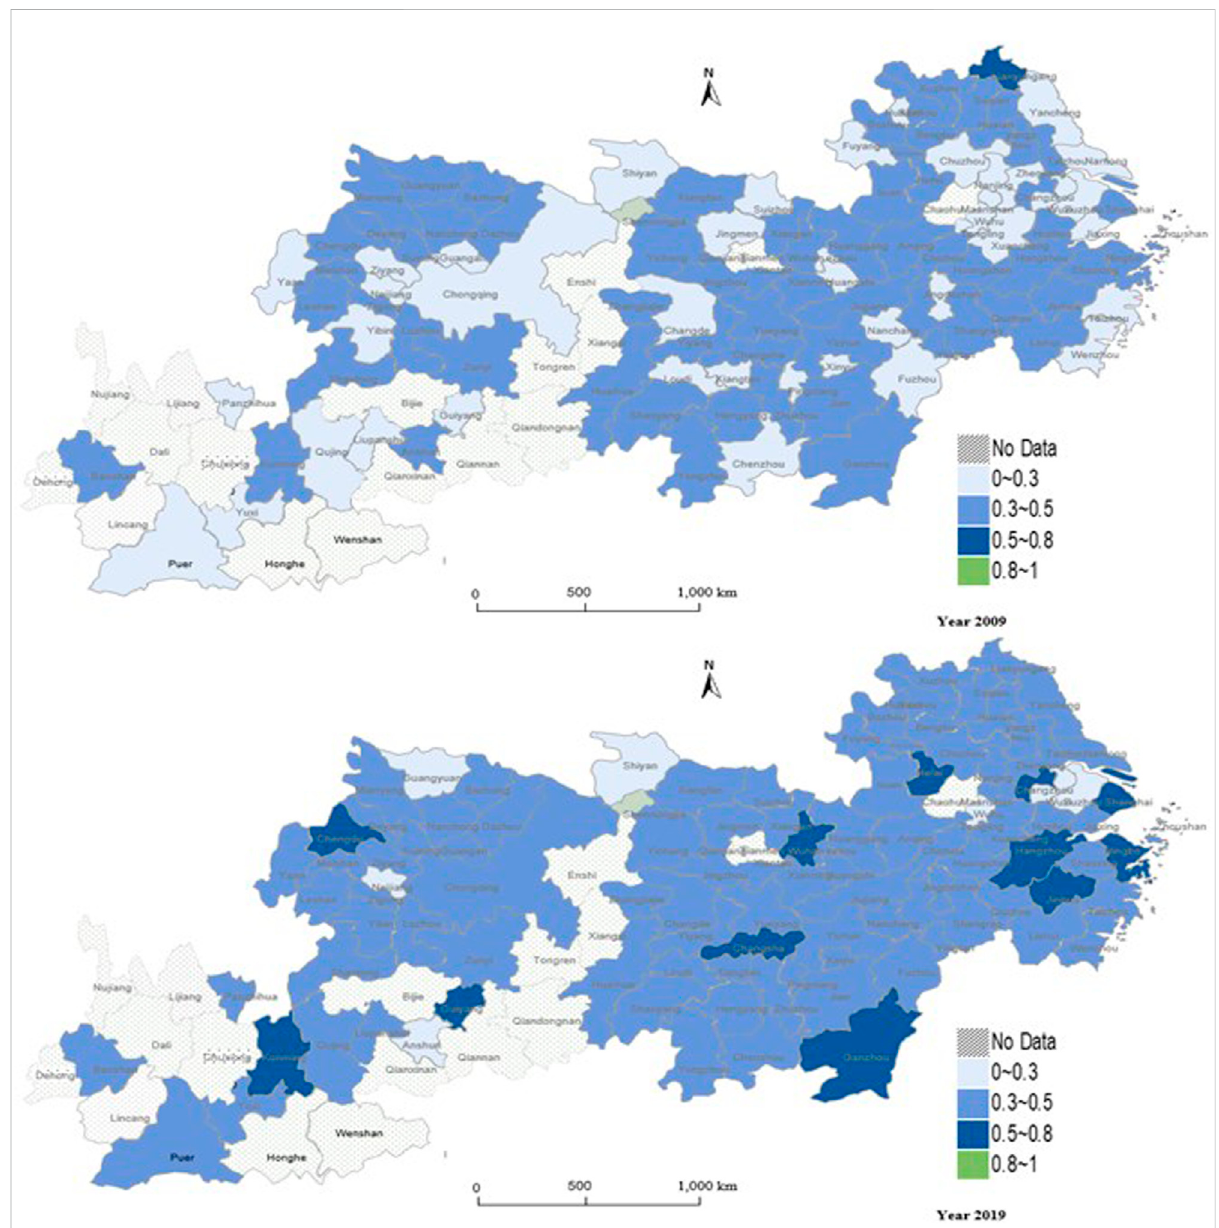
FIGURE 6 Spatial distribution of coupling degree between the USFD and green economic development in the YREB in 2009 and